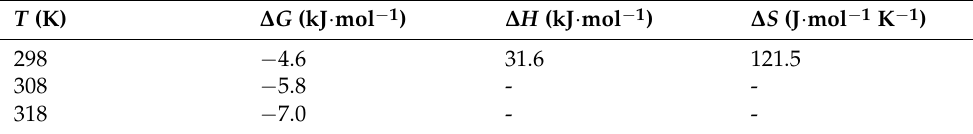
Table 4. Thermodynamic parameters for TC adsorbed by